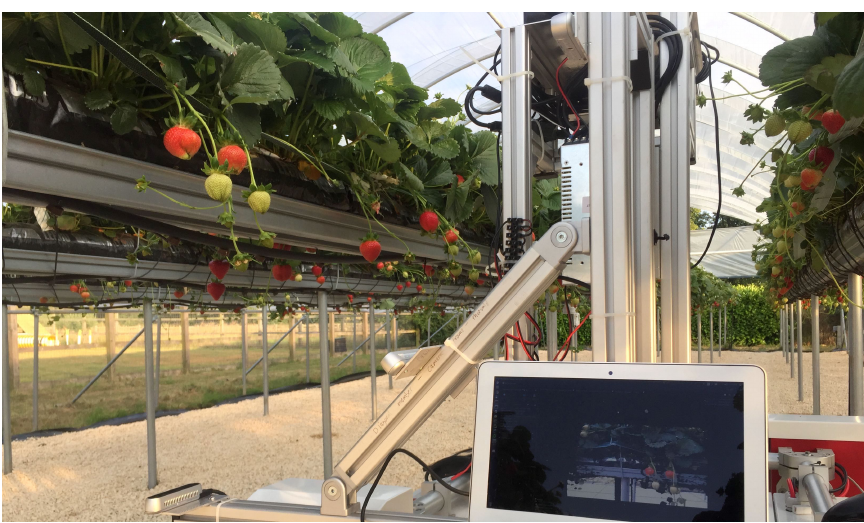
Figure 5. The image acquisition rig inside the strawberry polytunnels.